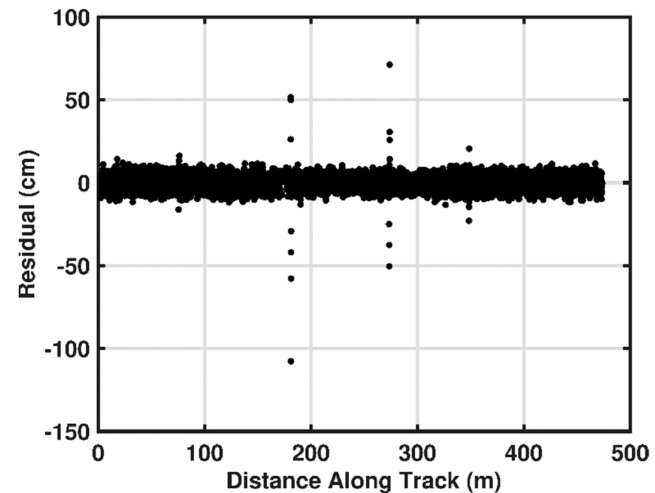
Figure 15. Range residuals (measured minus actual) from the data shown in Figure 14. The ground- truth elevation value was taken as the mean of all ranges within the